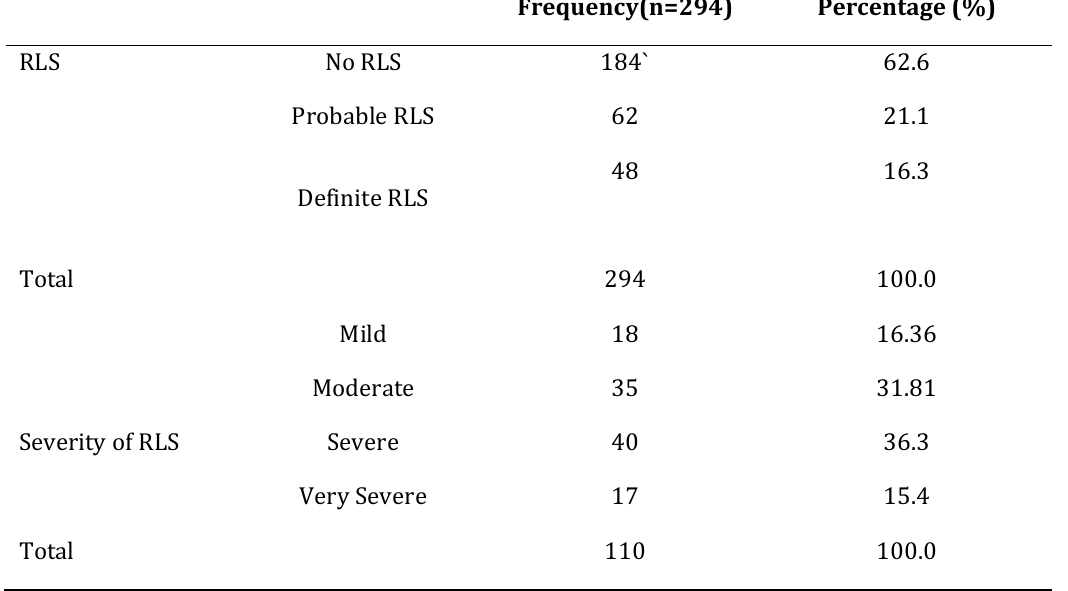
Table 3 : Prevalence of RLS in COPD patients and distribution of these patients according to the severity of RLS (n=294)